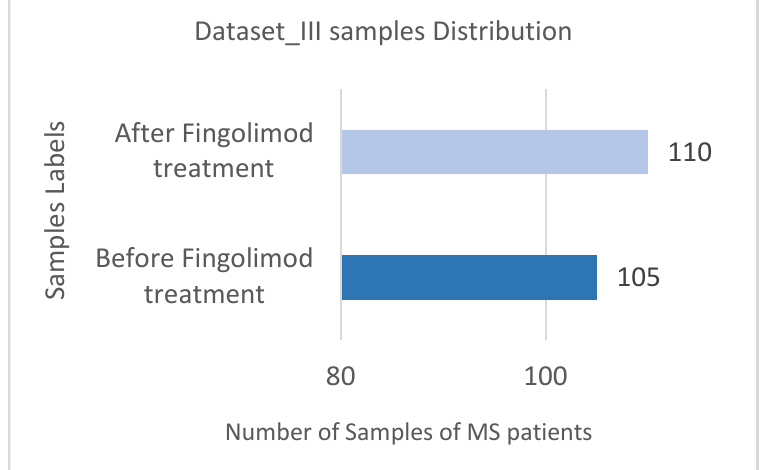
(a) six RA Cases samples; (b) six controls; (c) thirty synthetic samples categorized into five classes (A, B, C, D, and E) and each of these synthetic classes consists of six samples.